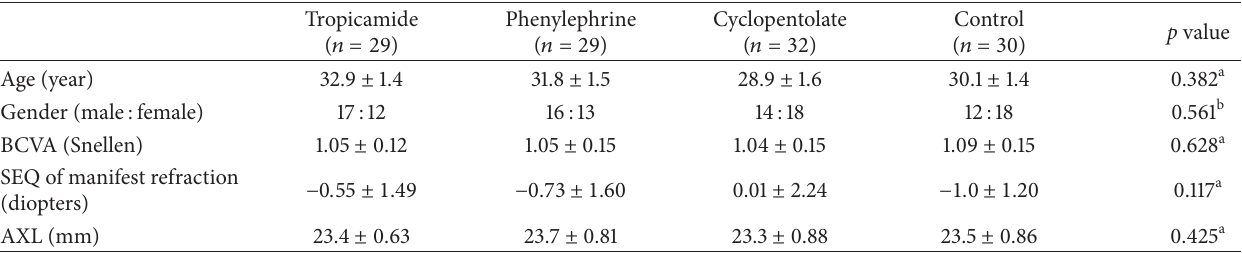
Table 1: A summary of demographics and ocular parameters in all